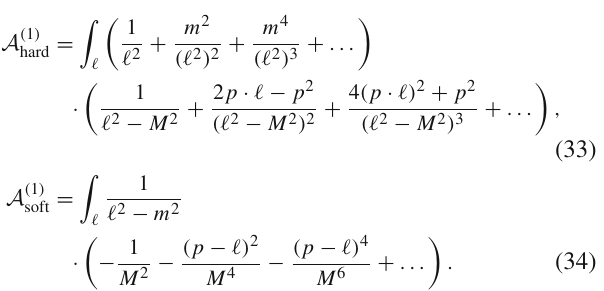
after the m + M ) 2 ) . The path of integration i